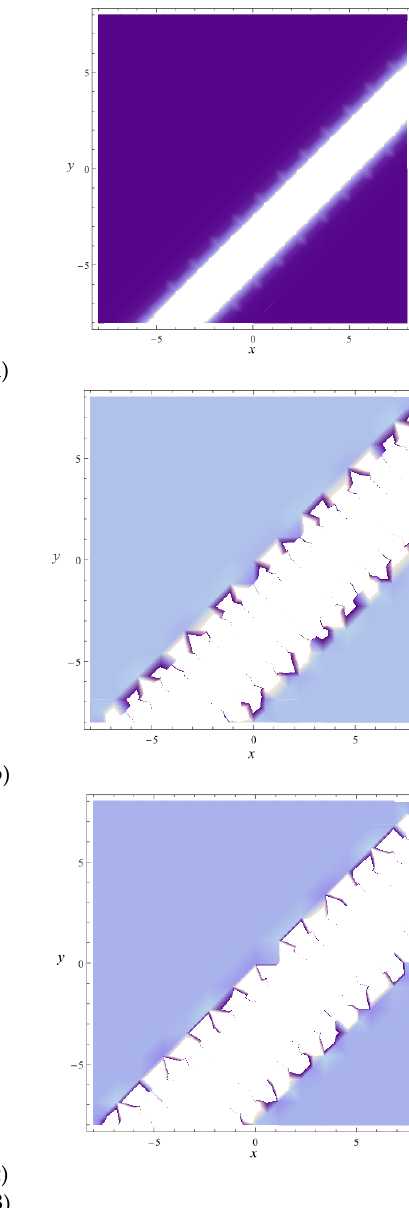
Figure 2. The AP, RP and IP of the SWS given by Equation (43) at t = 2. ( A ) The performance of p ( x , y , t ) . ( Aa ) The 3-D plot and density contour of the AP. ( Ab ) The 3-D plot and density contour of the RP. ( Ac ) The 3-D plot and density contour of the IP. ( B ) The performance of q ( x , y , t ) . ( Ba ) The 3-D plot and density contour of the AP. ( Bb ) The 3-D plot and density contour of the RP. ( Bc ) The 3-D plot and density contour of the IP.